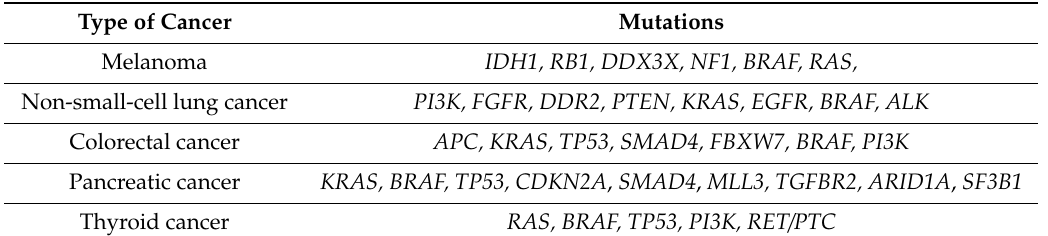
Table 1. Genetic drivers of